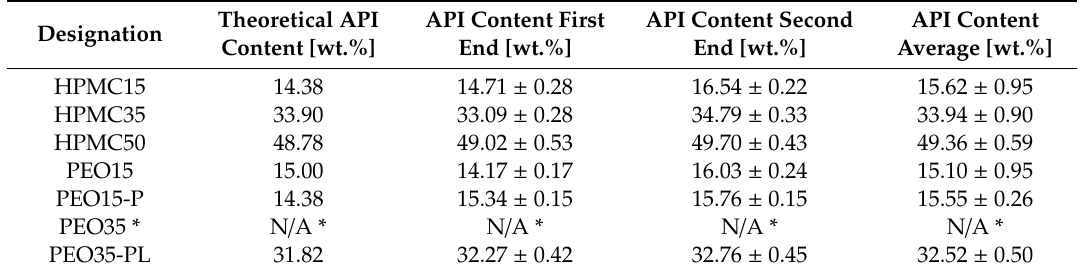
Table 5. Filament investigation for homogeneity of theophylline (in table API) distribution.